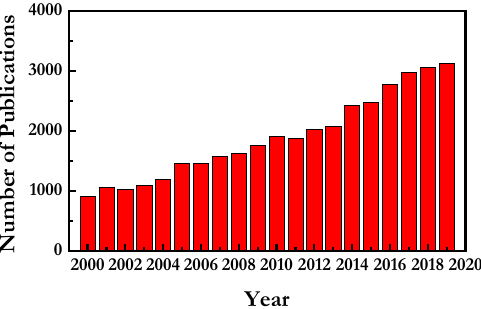
Figure 1. Number of publications per year devoted to the study of fluid interfaces (period 2000–2019) (source: Web of Science, Clarivate Analytics).